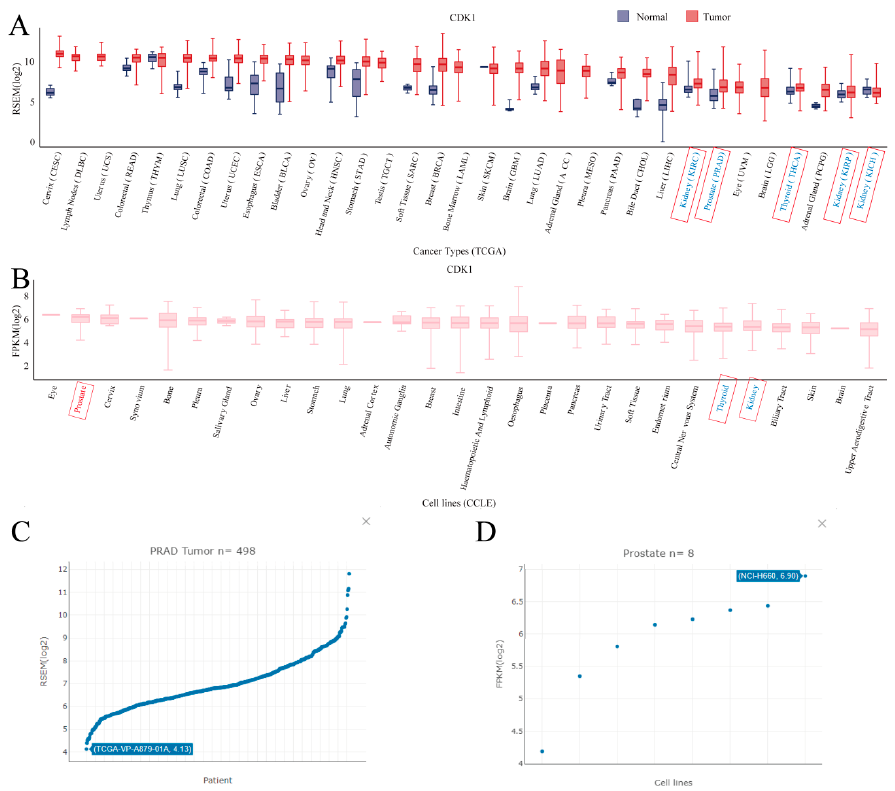
Figure 2. The use case of GEDS taking CDK1 as an example. The figure presents the results of CDK1 mRNA expression in the TCGA dataset ( A ) and CCLE dataset ( B ). Words in red and blue are the cancer types or tissues with high and low CDK1 expressions, respectively. The detailed expression of CDK1 in each prostate cancer sample ( C ) and cell line ( D ).